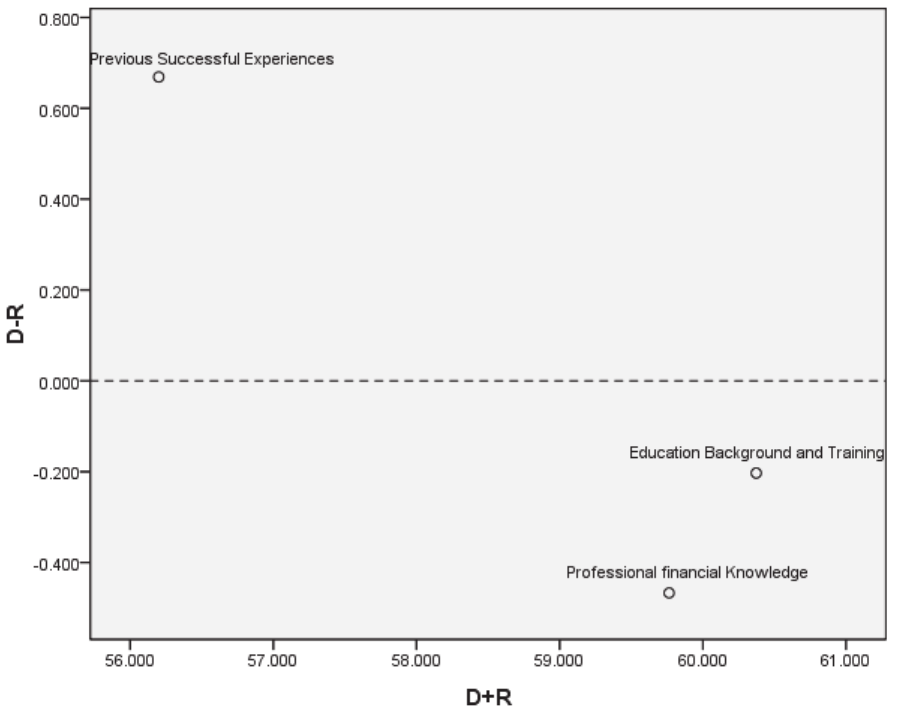
Figure 7. Causal diagram of sub ‐ aspects of managers’ learning and growth perspective criteria .